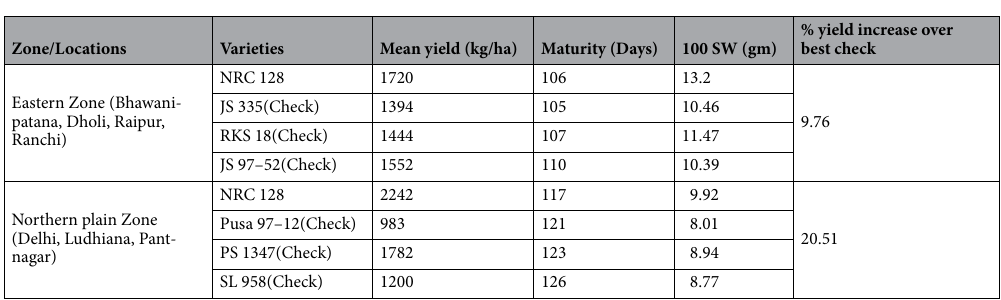
Zone/Locations Varieties Mean yield (kg/ha) Maturity (Days) 100 SW (gm)